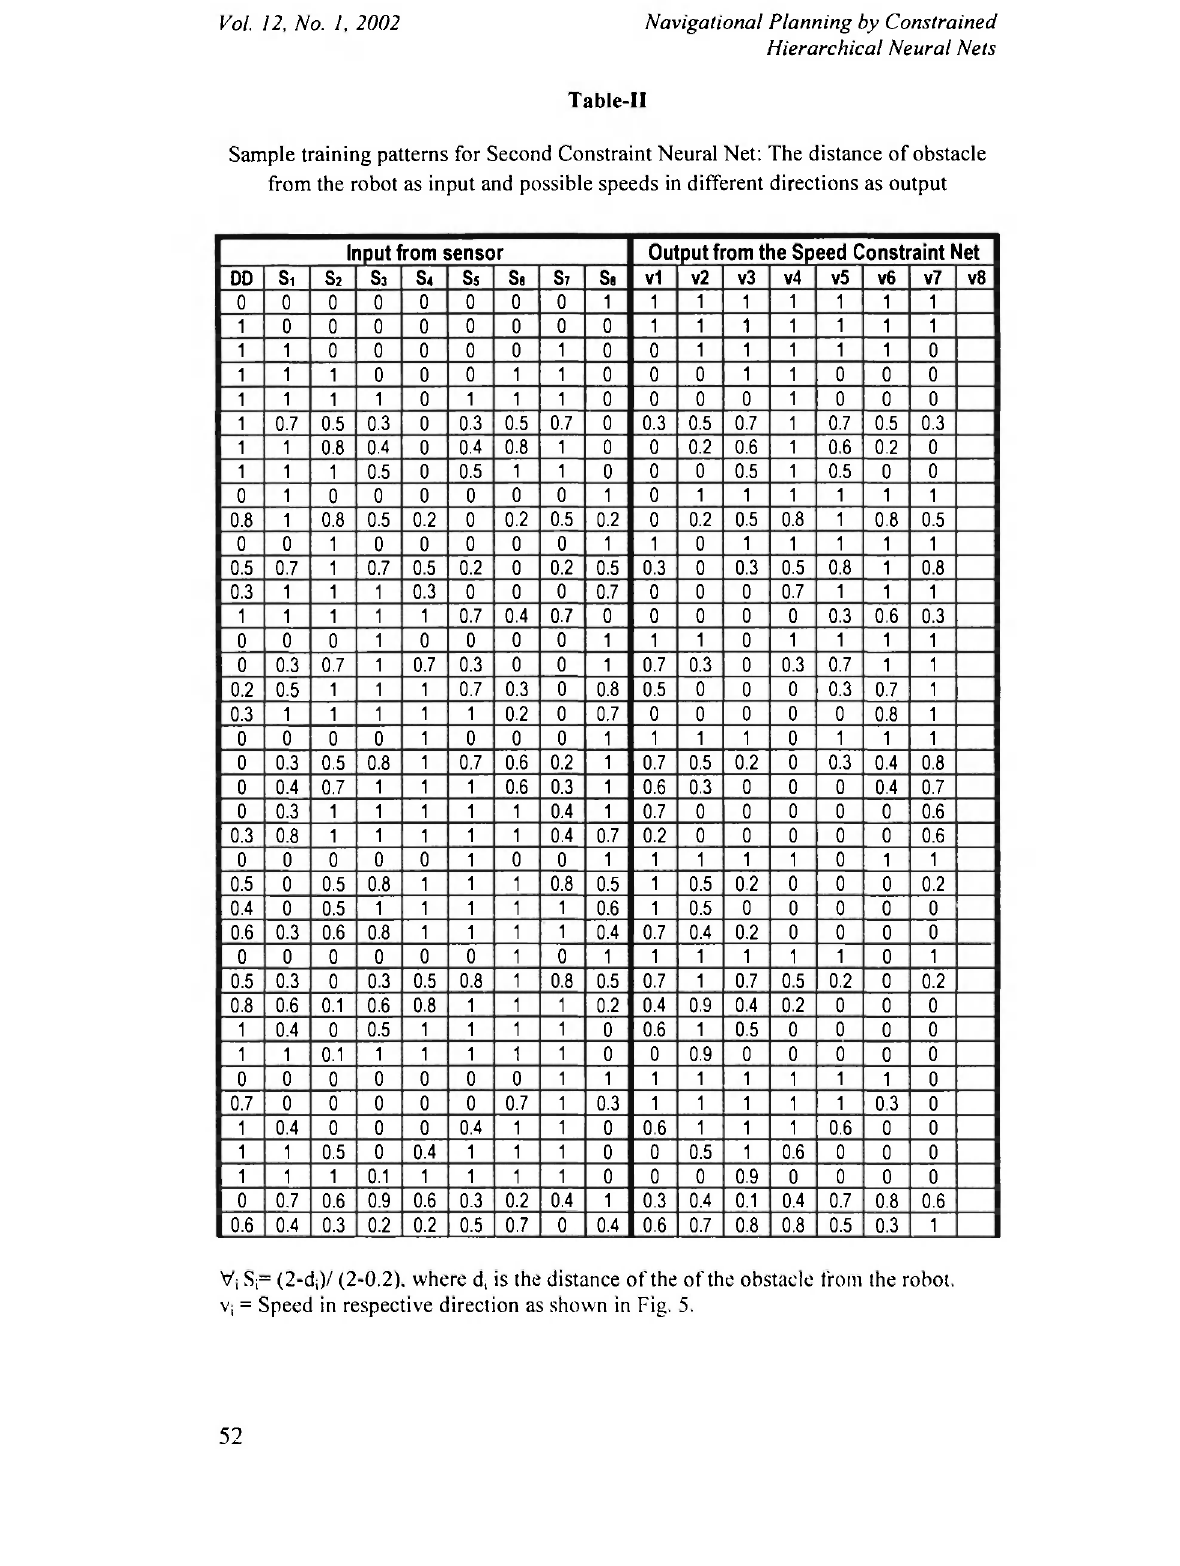
Sample training patterns for Second Constraint Neural Net: The distance of obstacle from the robot as input and possible speeds in different directions as